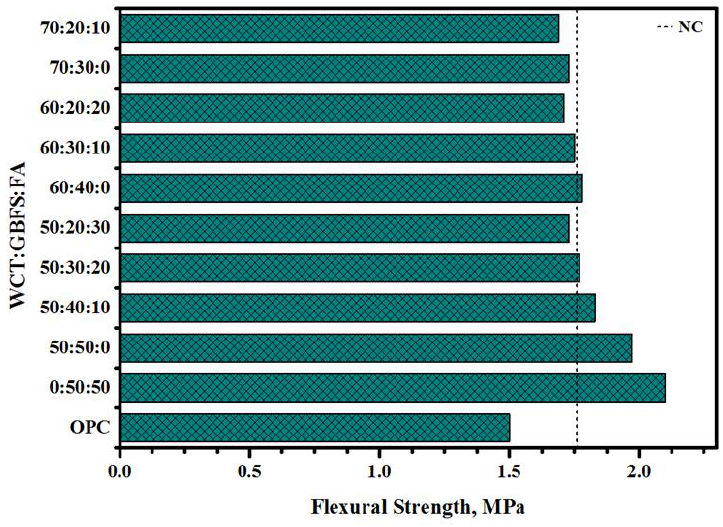
Figure 12. Impact of various WCT:GBFS:FA on the FS of four points of the repairing prisms.